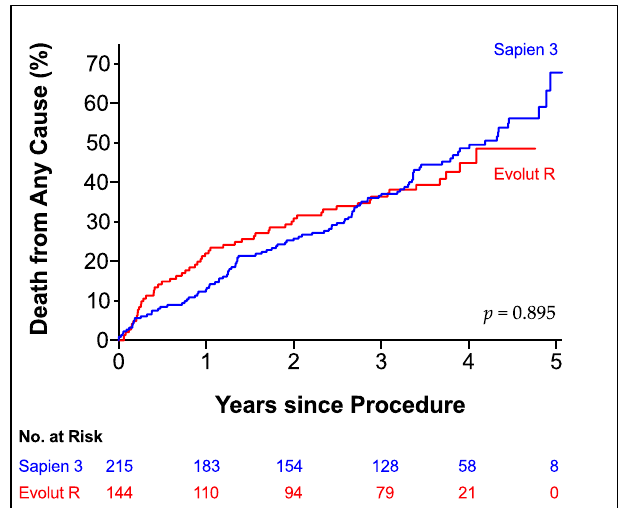
Figure 2. All-Cause Mortality. Kaplan-Meier Estimator of Death from any cause according to prosthesis type up to 5 years of follow-up. Edwards SAPIEN 3 (blue line); Medtronic Evolut R (red line).